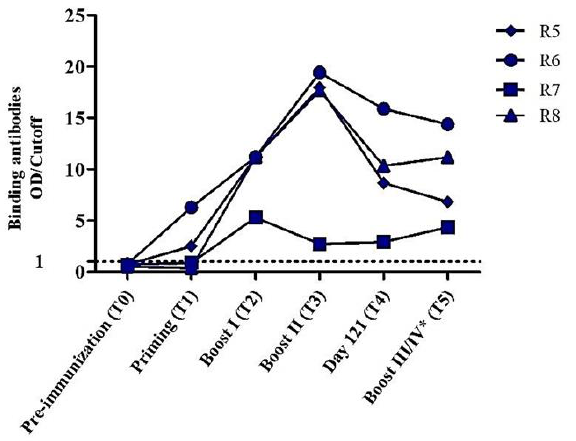
immunogens. Blue lines represent immunized mice from the respective group; black lines represent mice from control group (G1-M1-M2).